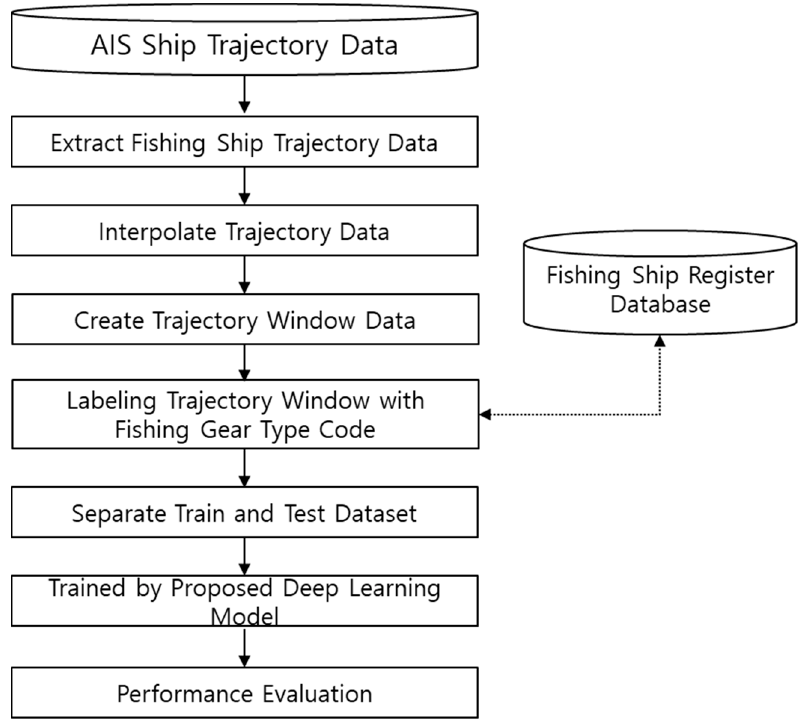
Figure 7. Experimental procedure for the proposed methods.